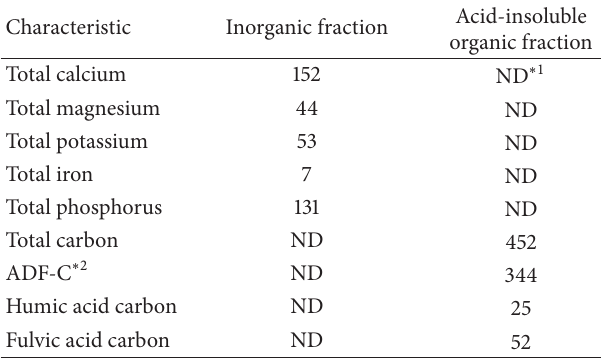
Table 2: Chemical properties of inorganic and acid-insoluble organic fractions used in this study (on the basis of air-dried weight, mg g −1 )